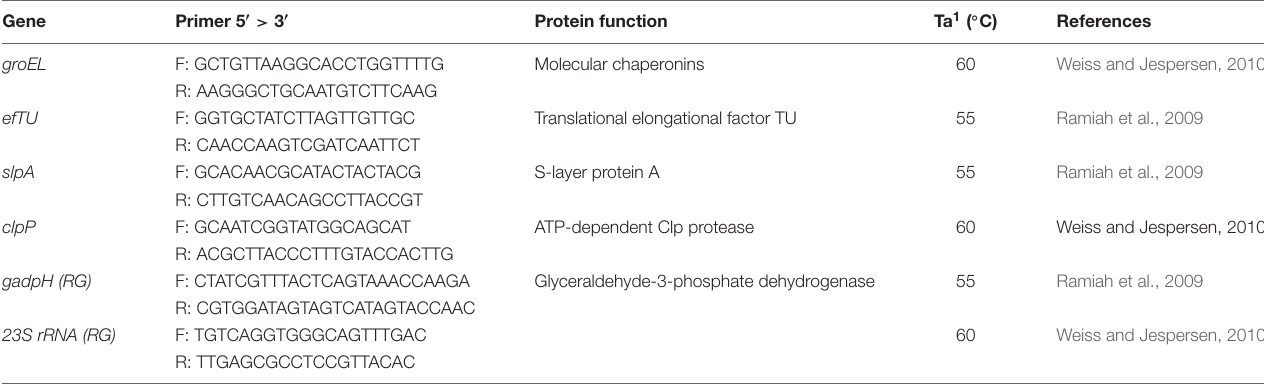
TABLE 1 | List of genes and primers and protein functions considered in this